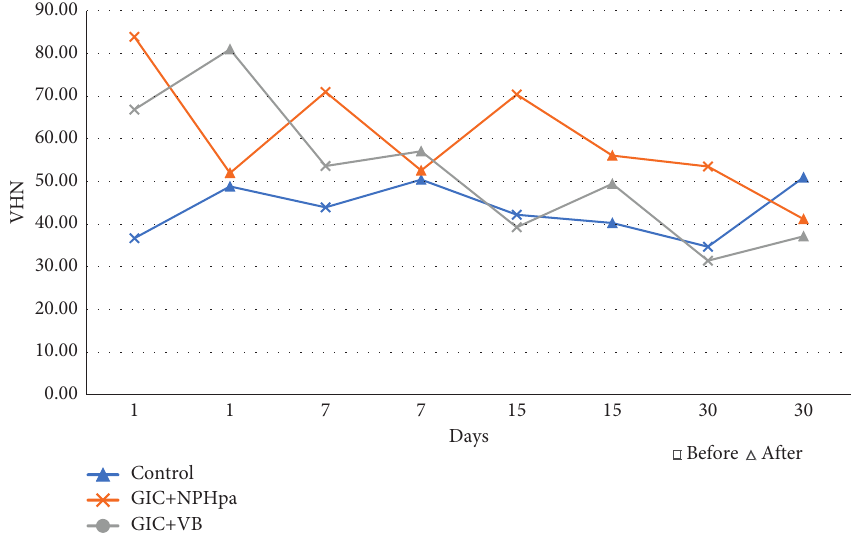
Figure 3: Variability of Vickers hardness (VHN) before and after brushing over time